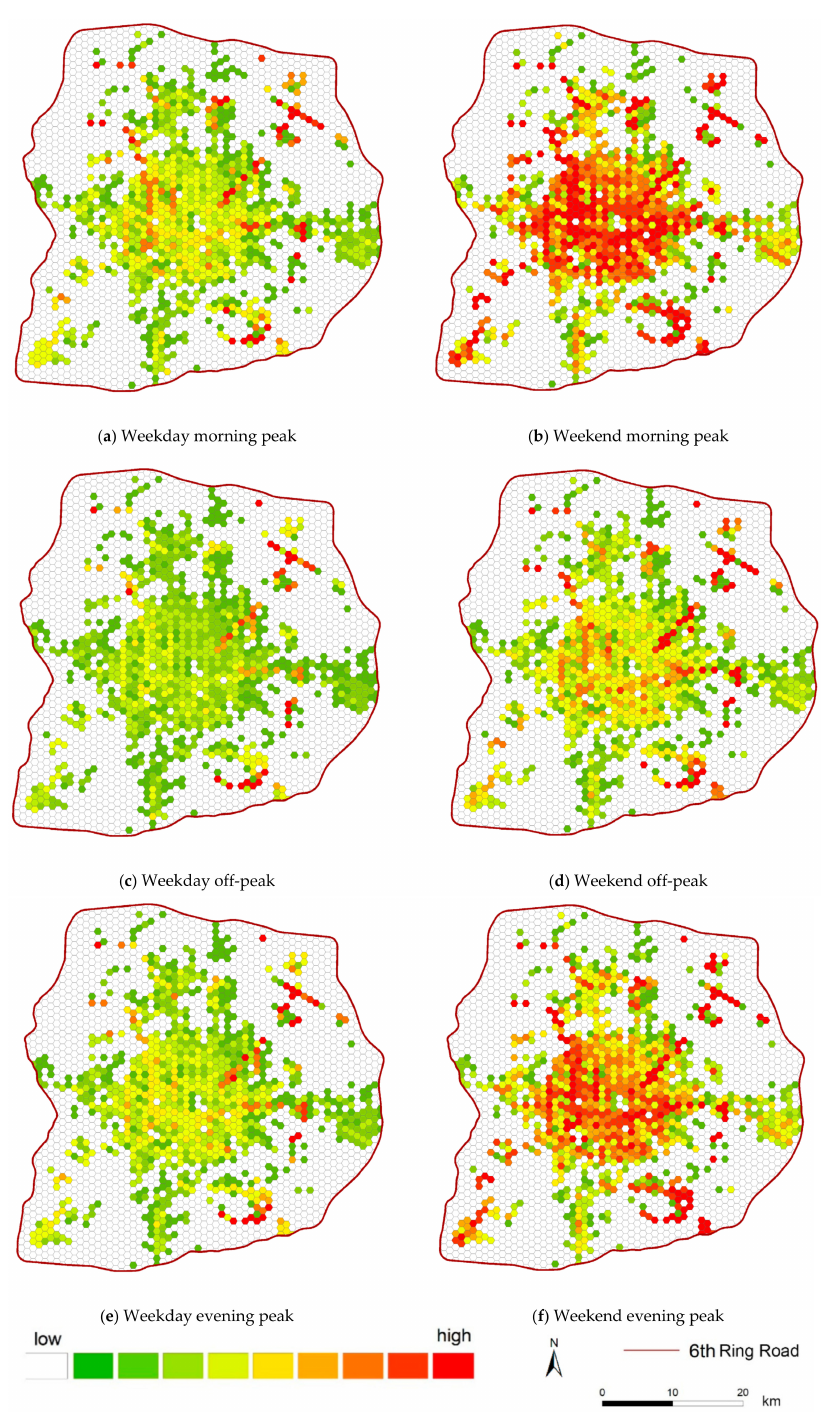
Figure 9. Medical service accessibility in different time periods, where ( a , c , e ) show the weekday dynamic accessibility and ( b , d , f ) show the weekend dynamic